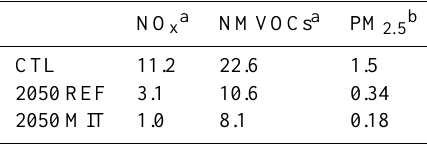
Table 2. Current time and future emission estimates (kt) over a 50km 2 area around extracted from the 1st model